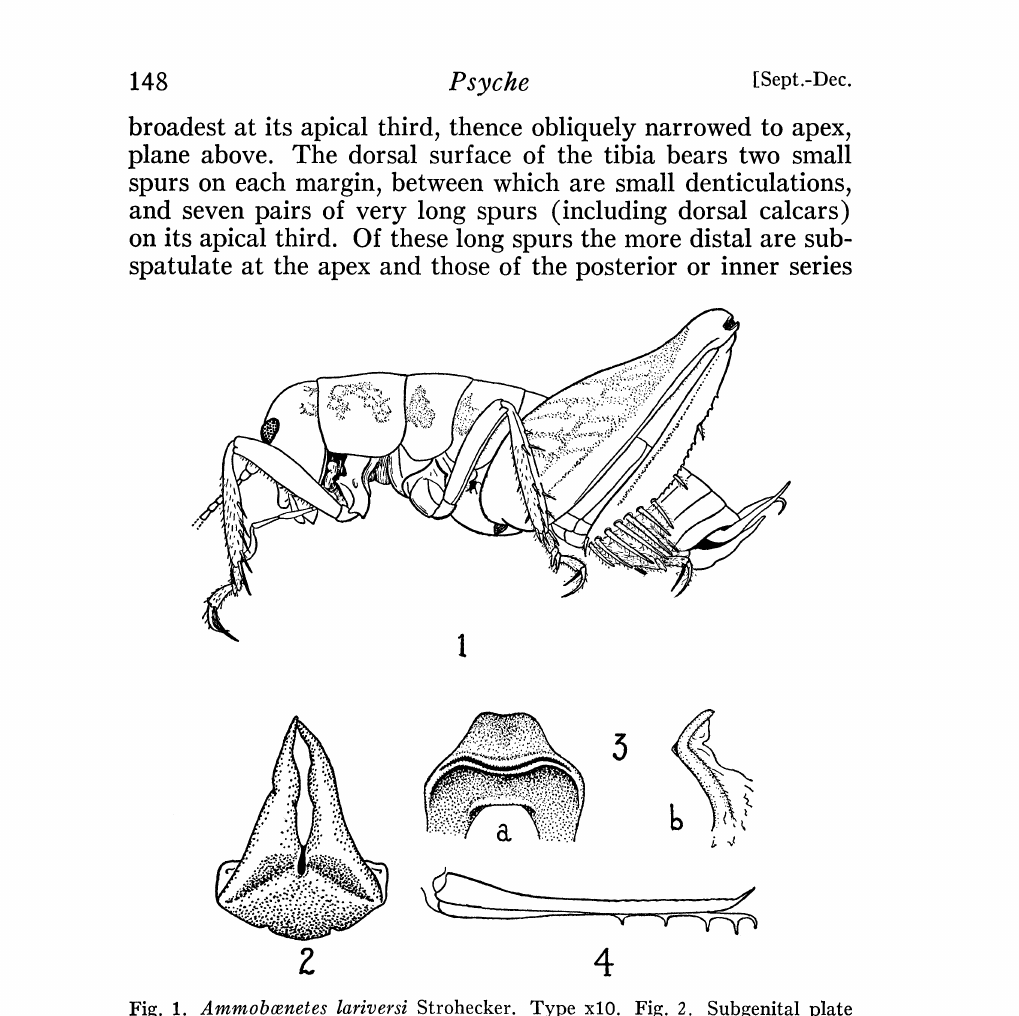
Fig. 1. Ammoboenetes lariversi Strohecker. Type xl0. Fig. 2. Subgenital plate of type. Fig. 3. Pseudosternite of paratype (a) posterior, (b) right lateral view. Fig. 4. Ovipositor of